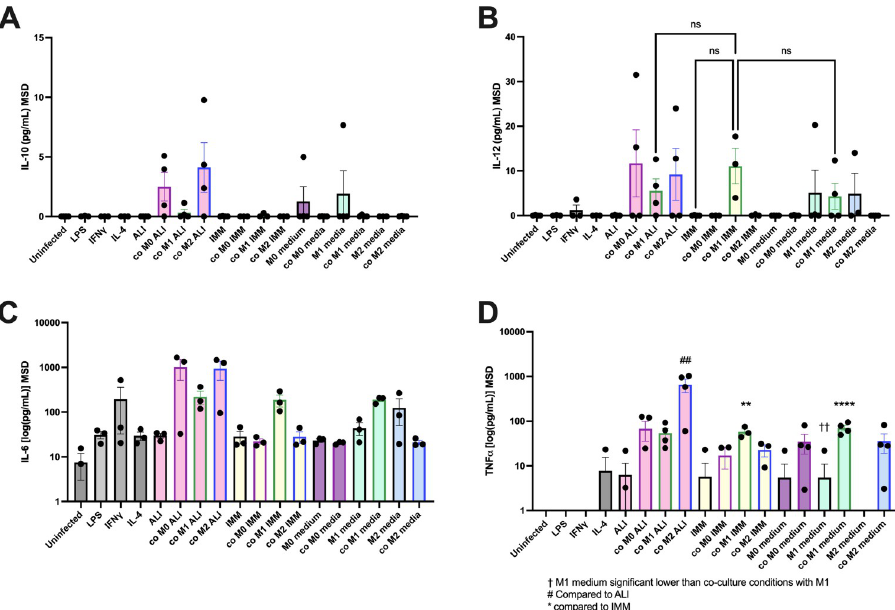
Fig 7. Meso Scale Discovery cytokine assay on media of macrophages and HBECs infected with RSV in co-culture. HBEC were placed in different media with or without co-culture with M0, M1, or M2 macrophages and infected with 0.15 MOI RSV. Media was collected from the basolateral side of the epithelia at 24 and 72 hours post infection and collected. Data for 24 hours is shown, as results at 72 hours were the same. Basolateral media or apical wash were assessed for the release of IL-10, IL-6, IL-12p70, or TNF α by Meso Scale Discovery (MSD) cytokine assay. � p < 0.05, �� p < 0.01, ��� p < 0.001, ���� p < 0.0001 compared to IMM or where indicated, or # p < 0.05, ## p < 0.01, ### p < 0.001, #### p < 0.0001 compared to ALI as assessed by ANOVA with Dunnett’s post hoc test, †† p < 0.01 as assessed by ANOVA with Tukey’s post hoc test comparing samples with M1 medium or M1 macrophages, n = 3–4.